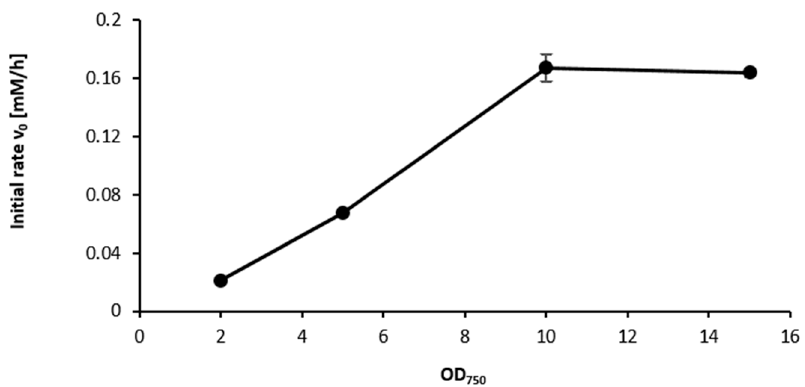
Figure 3. Biotransformation of a solution of cyclopentanone 1f (5 mM) by different amounts of Synechocystis sp. PCC6803 cells harbouring CHMO under light of 300 μ E m − 2 .